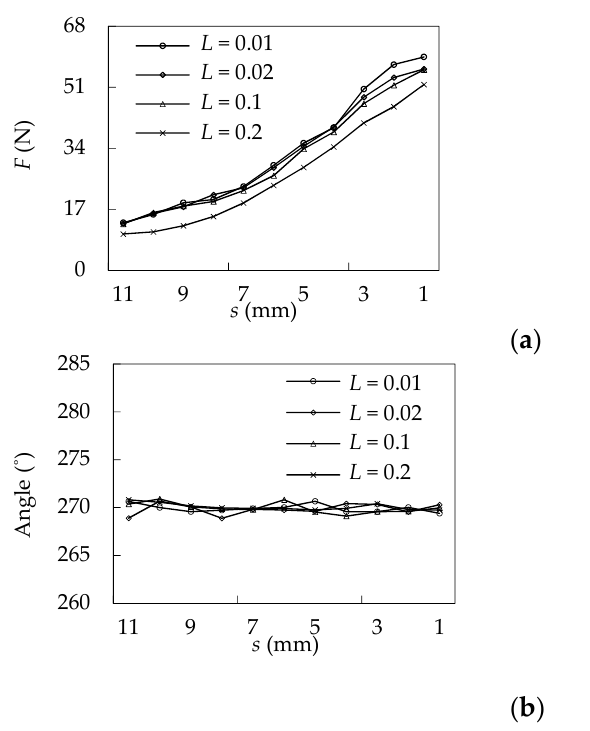
Figure 7. The electromagnetic force (EF) versus s (in the centerline of the PM slot): ( a ) the amplitude; ( b ) the phase.